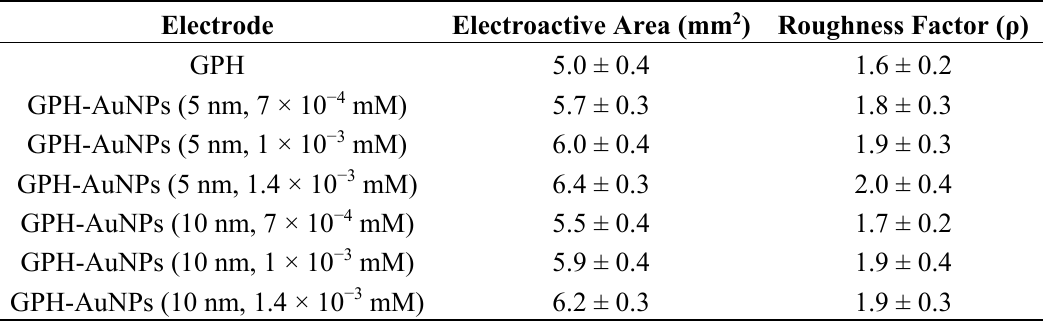
Figure 1. Cyclic voltammograms of 0.1 mM potassium ferricyanide solution at unmodified GPH (red curve) and at GPH modified with AuNPs of 5 nm diameter ( a ) and of 10 nm ( b ) at the following concentrations: 7 × 10 − 4 M (green curve), 1 × 10 − 3 M (black curve), 1.4 × 10 − 3 mM (blue curve). Experimental conditions: 0.1 M phosphate buffer pH 7; scan rate 5 m·Vs − 1 . Table 1. Values of the electroactive area and roughness factor of the unmodified and modified graphene-based screen-printed electrode (GPH) with 5 nm and 10 nm diameter gold nanoparticles (AuNPs) at different